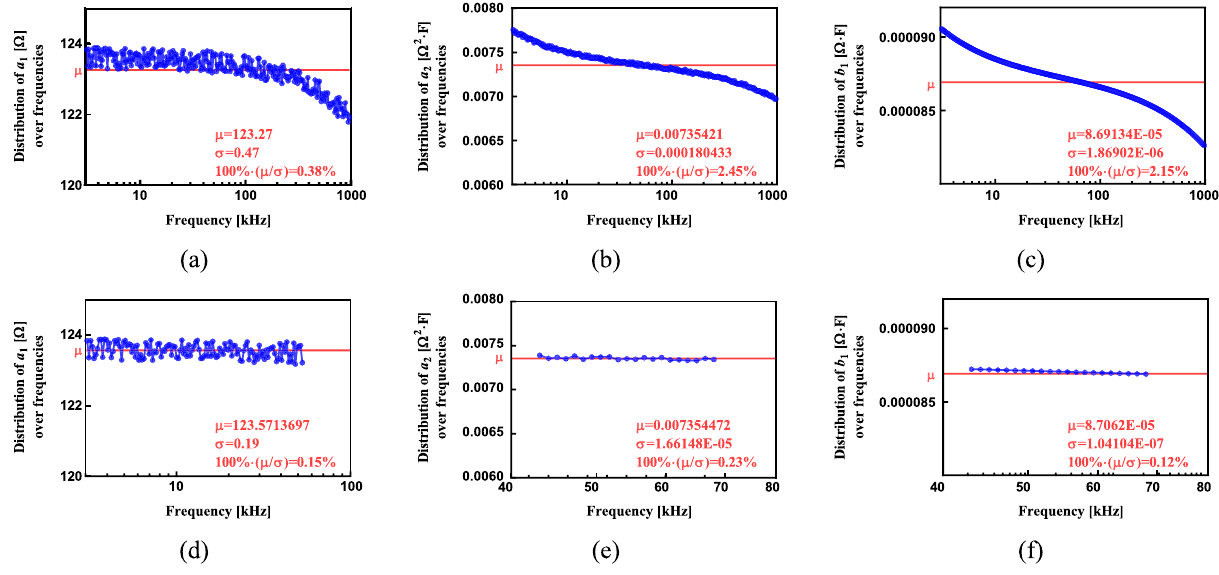
Figure 4. The frequency distribution of estimated values with Eqs. (10)–(12) in complete frequency range: ( a ) parameter a 1 , ( b ) parameter a 2 , ( c ) parameter b 1 ; and in reduced frequency range: ( d ) parameter a 1 , ( e ) parameter a 2 , ( f ) parameter b 1